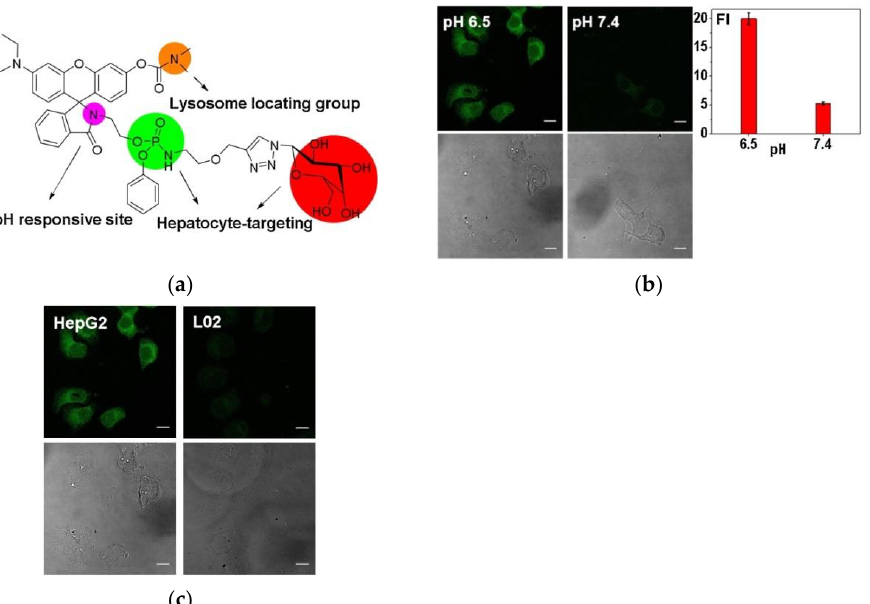
Figure 15. ( a ) Structure of probe HPL-1; ( b ) Fluorescence imaging of HPL-1 in HepG2 cells; ( c ) Fluorescence imaging of HPL-1 in HepG2 cells and L02 cells. Reproduced with permission from [76]. Copyright 2019 Elsevier B.V.